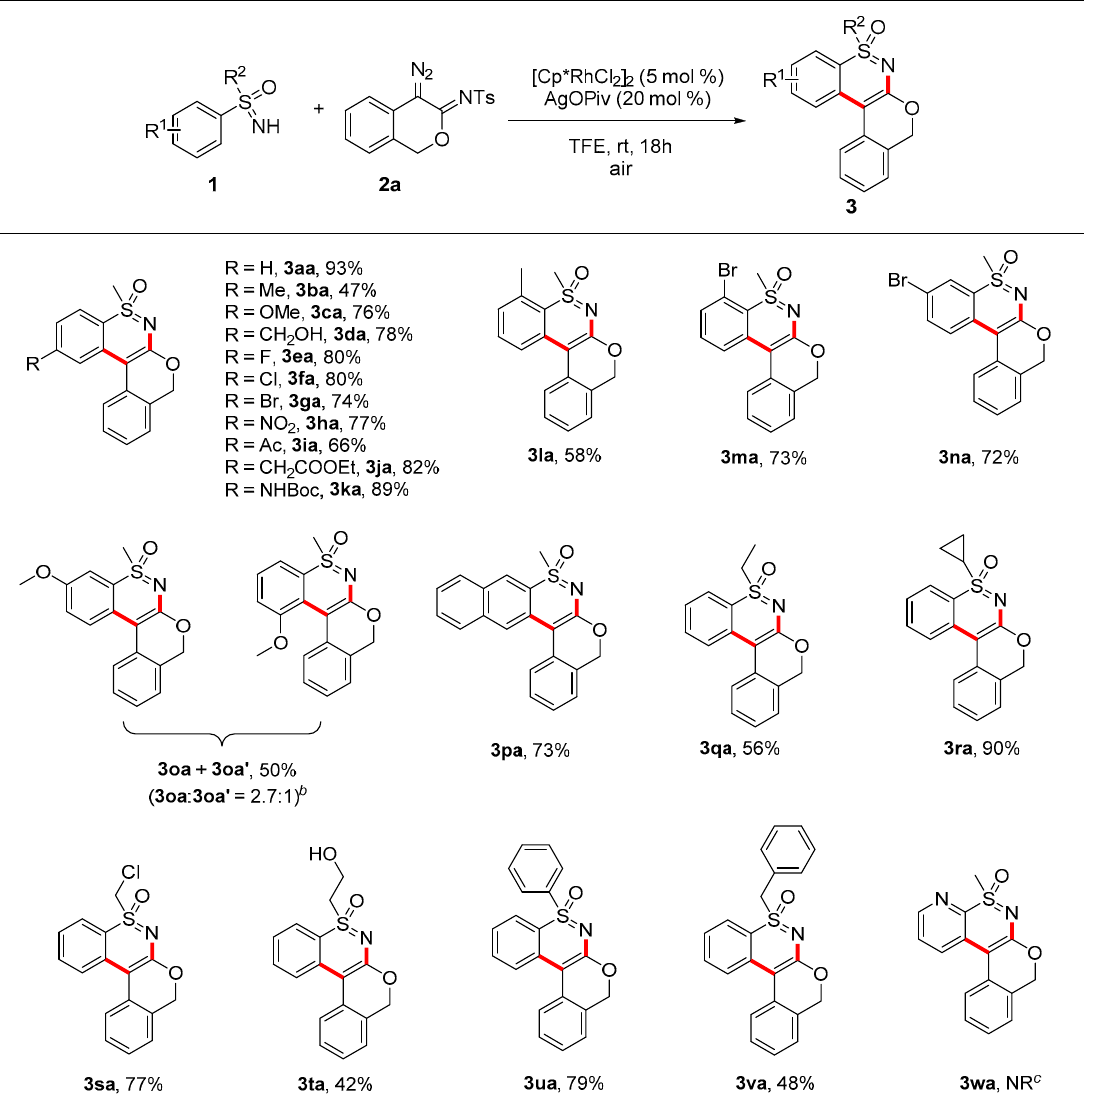
Table 2. Substrate scope of sulfoximines a .